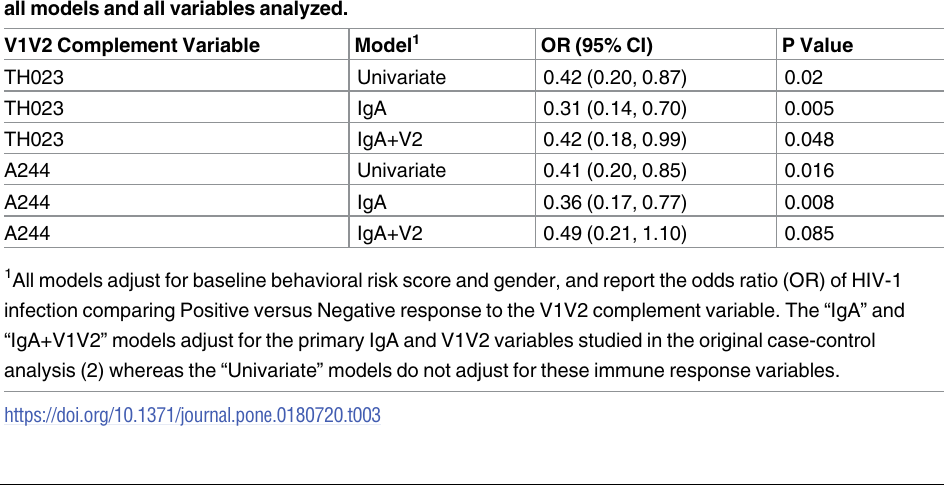
Table 3. Results testing the correlation of complement response call readouts with HIV-1 infection for all models and all variables analyzed.